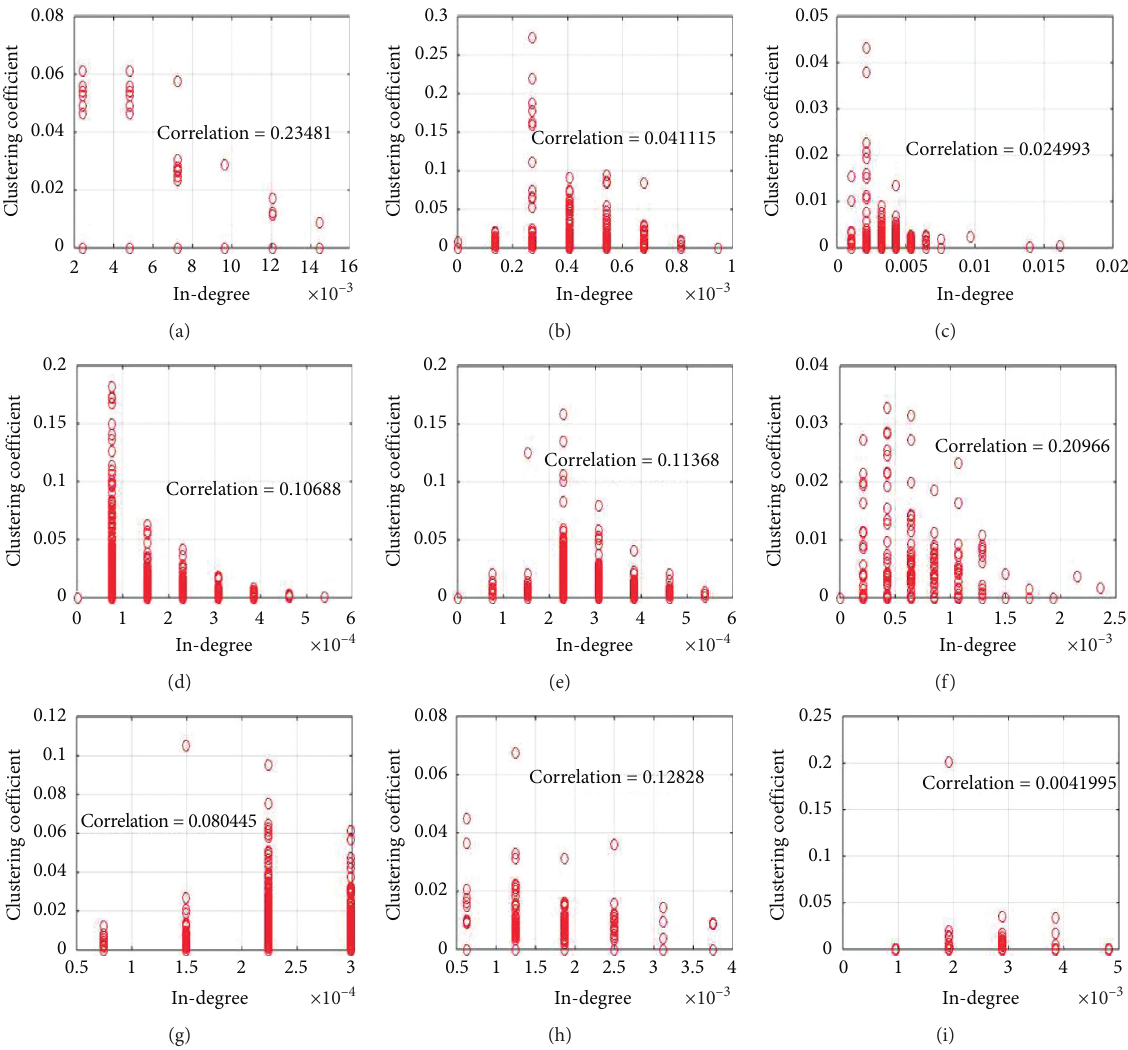
Figure 10: The correlation between normalized in-degree and clustering coefficient: (a) Anaheim; (b) Austin; (c) Barcelona; (d) Berlin;